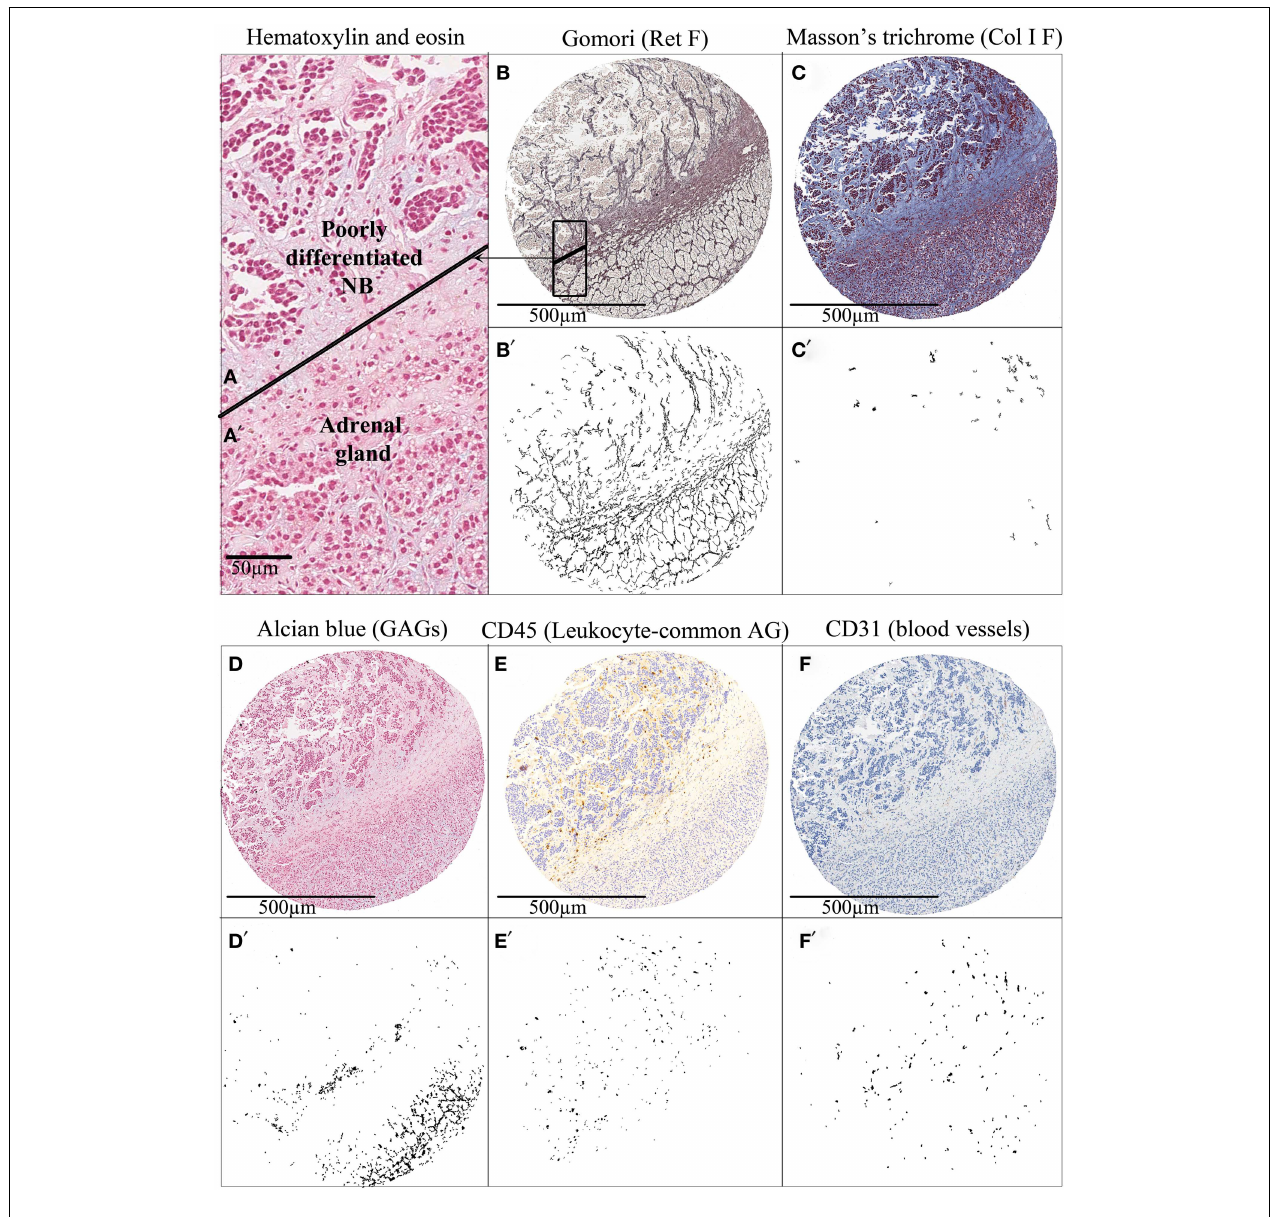
cylinder tissue was stained with (B) Gomori for Ret F, (C) Masson’s trichrome for Col I F, and (D) Alcian blue pH 2.5 for GAGs; and immunostained with (E) anti-CD45 for leukocyte-common antigen and (F) anti-CD31 for Blood vessels.Tumors tend to disrupt the topology of the ECM of the organ in which they settle, producing changes in biotensegrity. AG,